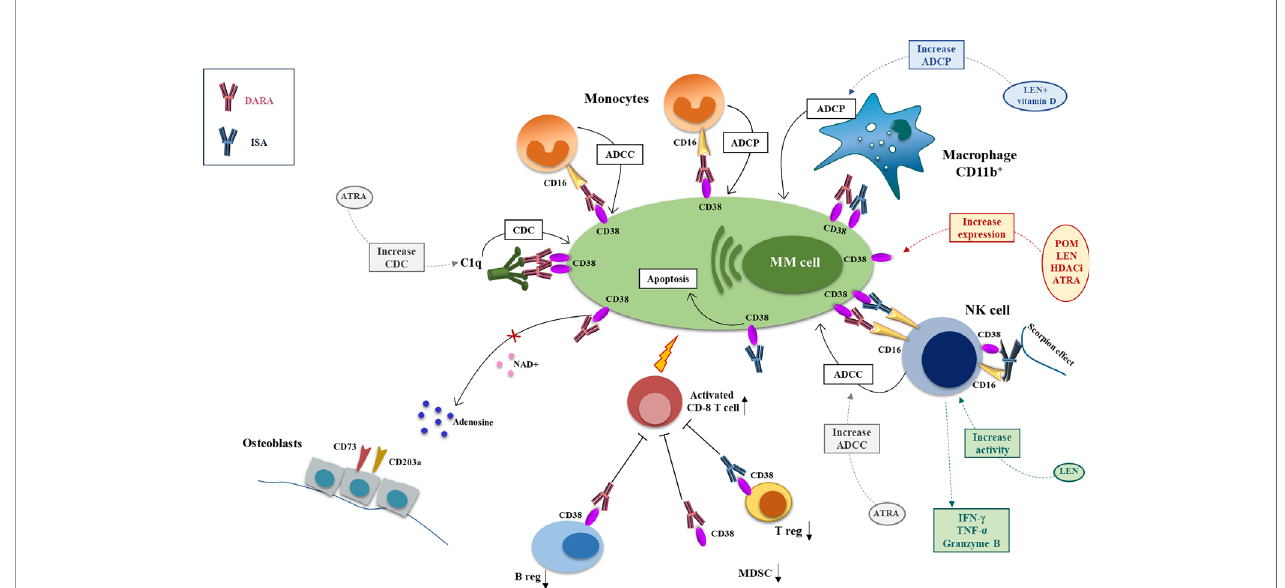
FIGURE 1 | Mechanism of action and major drug combination of anti-CD38 mAbs, daratutmumab, and isatuximab. The anti-CD38 mAbs exert their antimyeloma activity through different mechanisms of actions that can be potentiate by different anti-MM drugs. CDC is activated by engagement of the C1q by DARA and initiates the classical complement cascade and the recognition of MM cells by phagocytic cells and the production of the anaphylatoxins. This mechanism can be increased by ATRA. ADCC involves NK cell and monocytes that through CD16 recognize the anti-CD38 mAbs on MM cell surface and activate the cytotoxic process. ISA can activate directly the NK cells through the scorpion effect. NK cell activity can be boosted by ATRA and LEN. ADCP is carried by CD16+ monocytes and CD11b+ macrophage; LEN+ vitamin D can enhance anti-CD38 mAbs-mediated macrophages phagocytic activity. ISA can also have a direct anti-MM effect inducing MM cell apoptosis. DARA has also an immunomodulatory function downregulating the immunosuppressor ADO, diminishing Breg and MDSCs and activating CD8+ T cells. ISA exerts its immunomodulating potential downregulating Treg (DARA, daratumumab; ISA, isatuximab; CDC, complement depend cytotoxicity; ADCC, antibody depend cytotoxicity; ADCP, antibody depend phagocytosis; ATRA, all-trans retinoic acid; LEN,